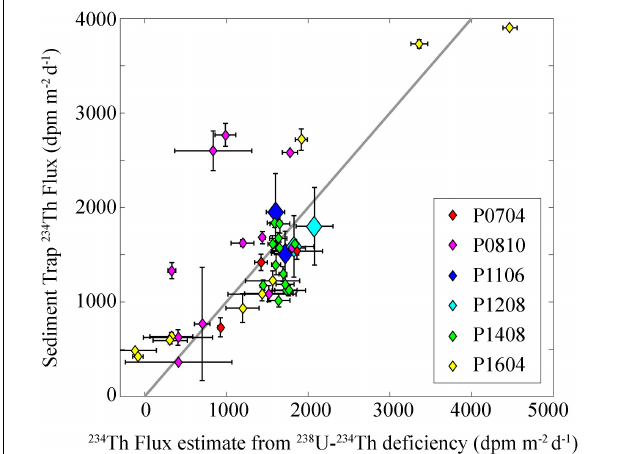
FIGURE 2 | Comparison of sediment trap and 238 U– 234 Th deficiency measurements. Y -axis is 234 Th flux directly measured in sediment traps. X -axis is 234 Th flux estimated during the same cycle from 238 U– 234 Th deficiency using a one-dimensional steady-state model without upwelling or diffusion. Note that for the P1106 and P1208 cruises, we plot only two data points each (representing cruise average results at the base of the euphotic zone or at 100 m). These cruise averages were used instead of a separate point for each cycle, because at the smaller spatial scales sampled on these “front” cruises 234 Th spatial patterns are likely driven as strongly by advection as by contemporaneous sinking